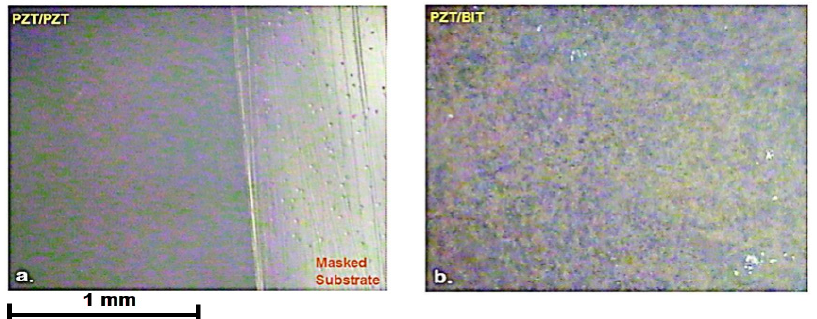
Figure 4. Optical microscopic images, composite films of ( a ) PZT/PZT on S 5 and ( b ) PZT/BiT on L 5 .